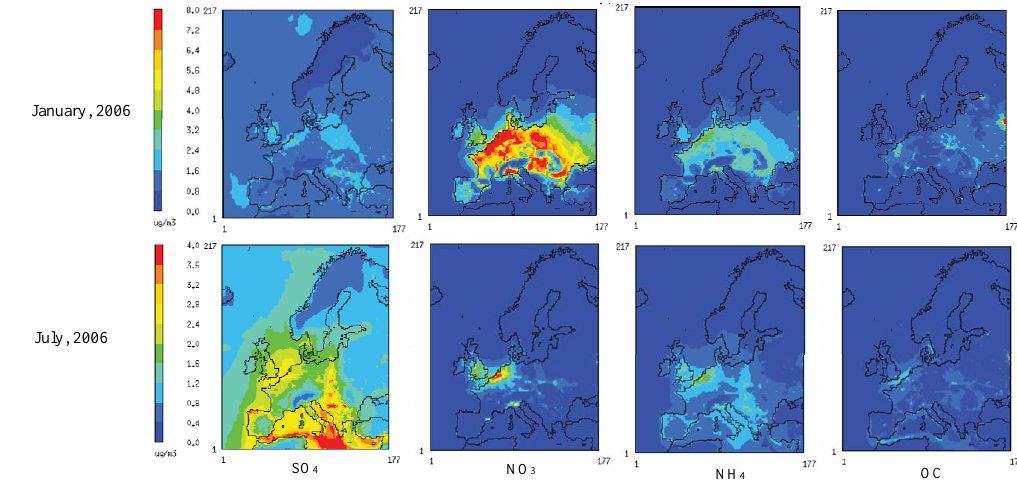
Fig. 3. Simulated PM 2 . 5 component daily average concentrations for January and July 2006.